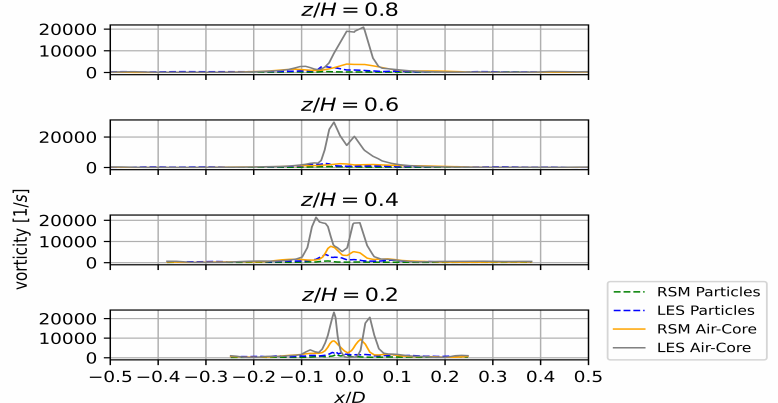
Figure 20. Axial velocities (m/s) as a function of the normalised x co-ordinate at various heights at flow-time 4 s for the simulations with the particles included and at flow-time 2 s for the air-core only simulations.